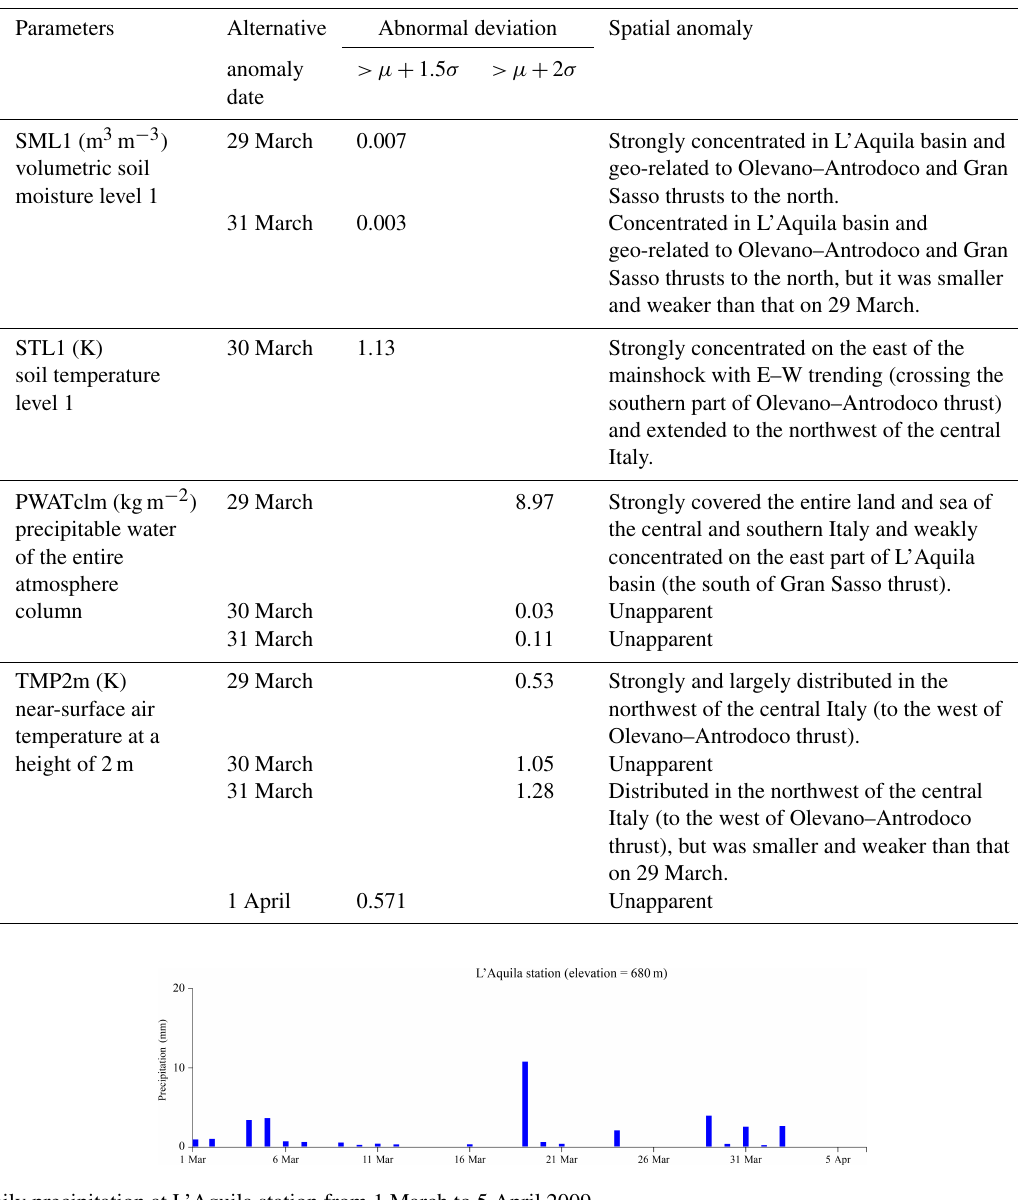
Table 2. Hydrothermal parameter anomalies from 29 March to 1 April 2009 (quasi-synchronous period).